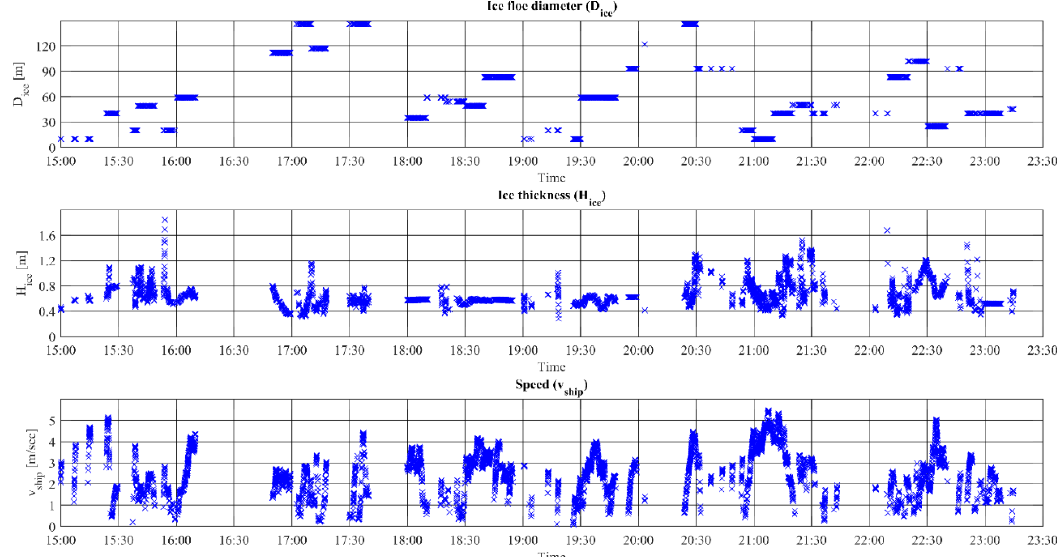
Figure 4. Extract from data set B, showing how the measured ice floe diameter, ice thickness and speed vary during a selected period of 8 h.